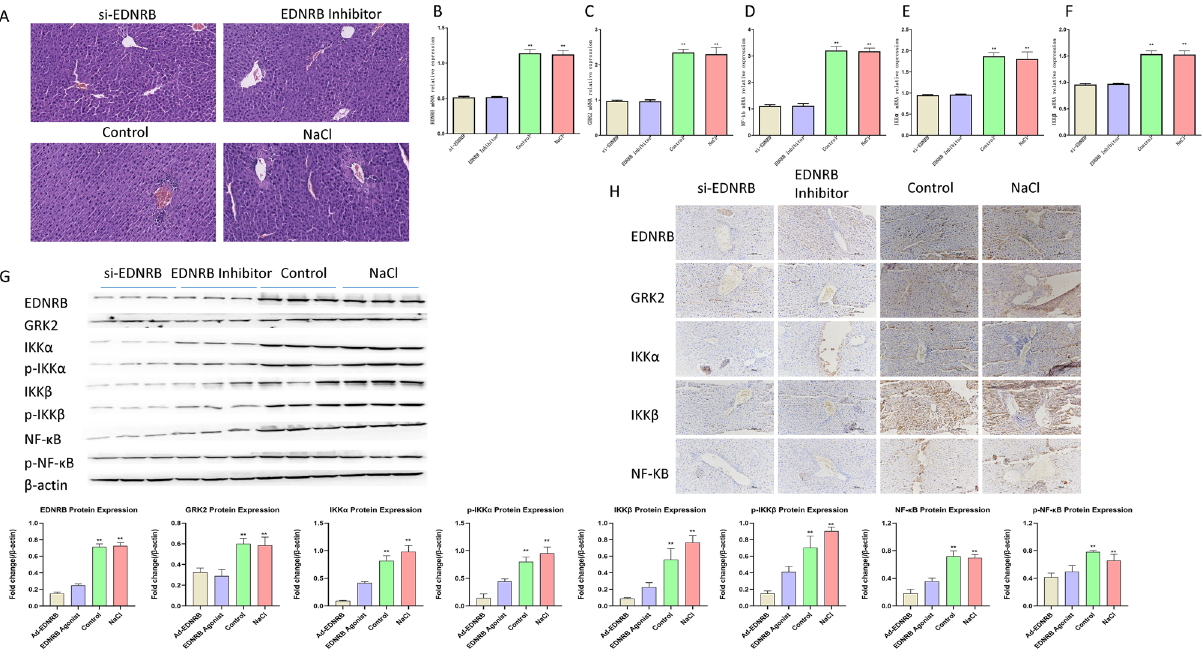
Figure 7. EDNRB knockdown or inhibition alleviated liver pathologic damage by suppressing GRK2 expression and inactivating NF-κB pathway in PBC mice. ( A ) HE staining of liver tissues of mice injected with normal saline (NaCl), control adenoviruses (Control), Ad-shEDNRB adenoviruses (Si-EDNRB), or EDNRB inhibitor Bosentan (EDNRB inhibitor). Each group contained 10 mice. ( B – F ) The mRNA levels of EDNRB, GRK2, NF-κB, IKKα, and IKKβ were measured with RT-qPCR assay in liver samples of mice injected with normal saline, control adenoviruses, Ad-shEDNRB adenoviruses, or EDNRB inhibitor Bosentan. ( G ) The protein levels of EDNRB, GRK2, NF-κB, IKKα, IKKβ, p-NF-κB, p-IKKα and p-IKKβ were detected via western blotting technique in liver tissues of mice injected with normal saline, control adenoviruses, Ad-shEDNRB adenoviruses, or EDNRB inhibitor Bosentan. ( H ) Levels of EDNRB, GRK2, NF-κB, IKKα, and IKKβ proteins were measured through IHC assay in liver tissues of mice injected with normal saline, control adenoviruses, Ad-shEDNRB adenoviruses, or EDNRB inhibitor